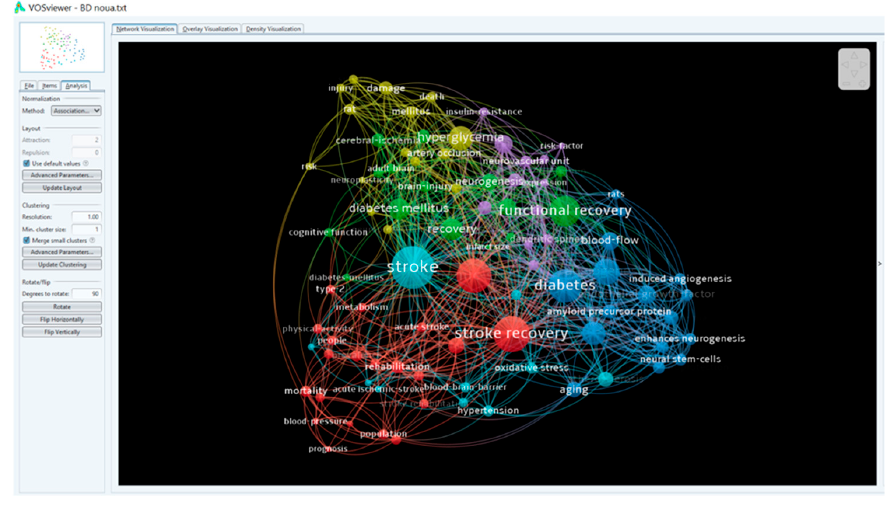
Figure 2. Keyword density map.